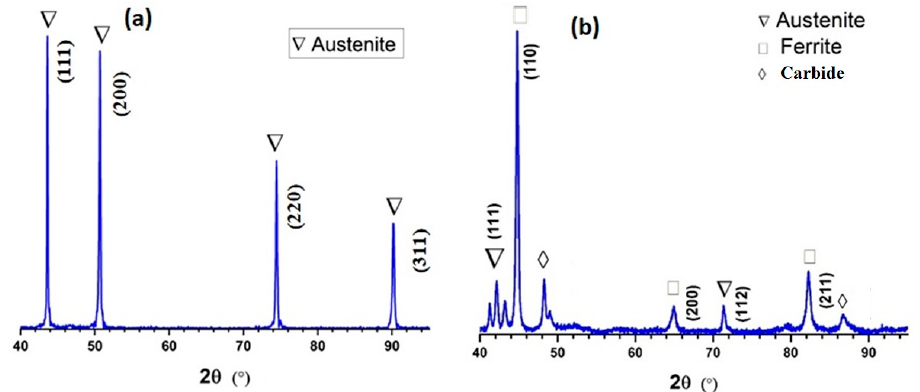
Figure 8. XRD analysis of weld sample ( a ) 310 SS ( b ) 410 SS.